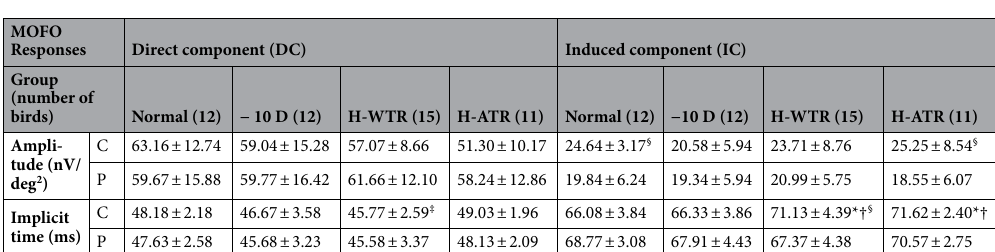
Figure 2. Effects of lens treatment and retinal region on ERG responses. ( a ) Averaged central and peripheral MOFO waveforms from normal (Grey) and three lens treatment groups (Black: − 10 D, n = 12; Blue: H-WTR, n = 15; and Red: H-ATR, n = 11). Note that the waveforms are normalized at the starting point for easy comparison. Boundaries of grey area mark the upper and lower limits of 95% CI of the mean waveform from the normal eyes (n = 12). The blue and red boxes enclose the direct (DC) and induced (IC) components, respectively. Bar graphs shows the amplitude (left) and implicit time (right) of direct ( b ) and induced ( c ) components from the normal and the three lens treatment groups. A mixed-model ANOVA was used to compare the differences in ERG responses (amplitude and implicit time) within groups (central versus peripheral) and between groups (across 4 groups: − 10 D, H-WTR & H-ATR) with Bonferroni corrections. The level of significance is indicated as follows: *p < 0.05, comparisons between groups (normal vs three treatment groups); † p < 0.05, comparisons between – 10 D and two sphero-cylindrical lenses treated groups; ‡ p < 0.05, comparisons between two sphero- cylindrical lenses treated groups (H-WTR and H-ATR); and § p < 0.05, comparisons within groups (central vs peripheral) between regions. Compared to normal and -10 D group, both sphero-cylindrical lens-wear groups (H-WTR and H-ATR) had delayed induced component (longer IC implicit time) in the central region. Both normal and H-ATR groups had significantly higher IC amplitude in the central than peripheral.